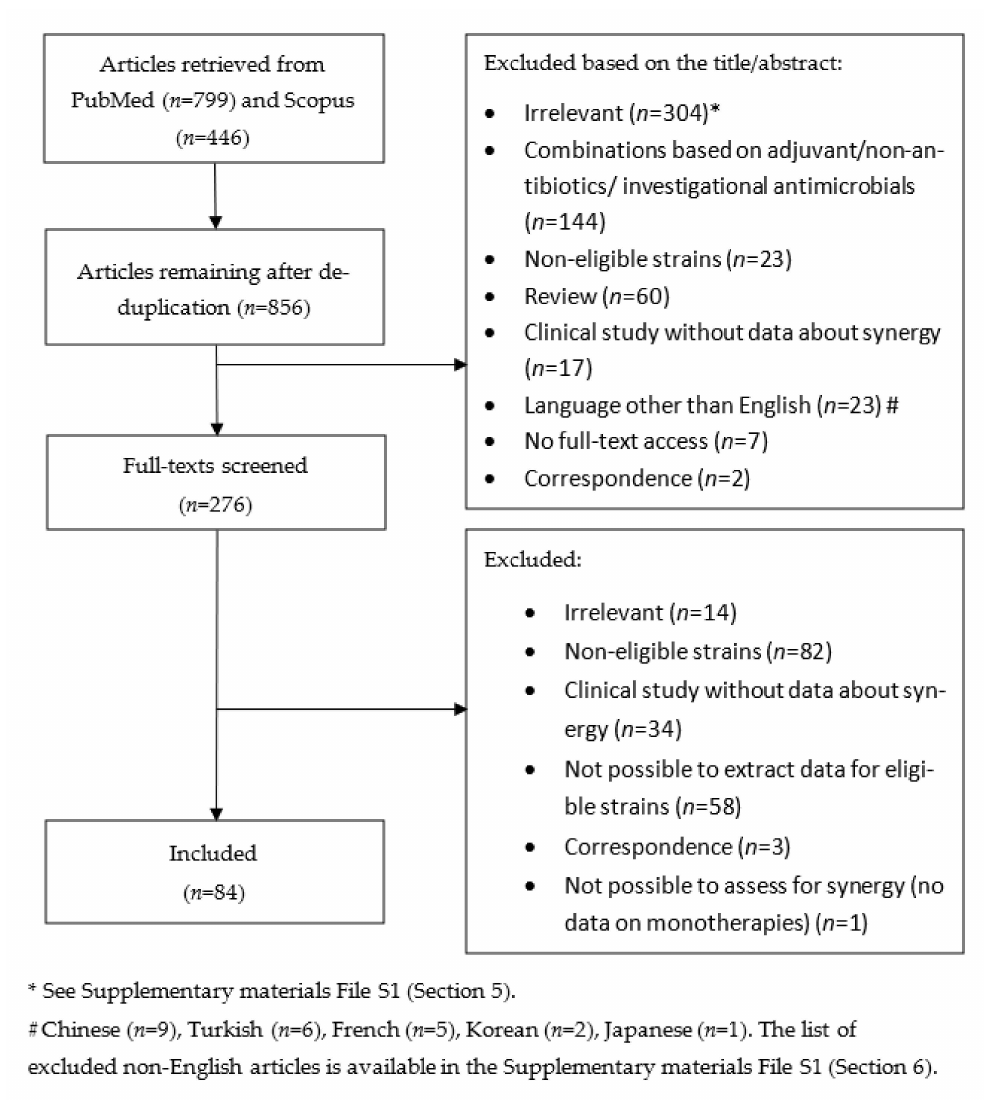
Figure 1. Flow chart of the